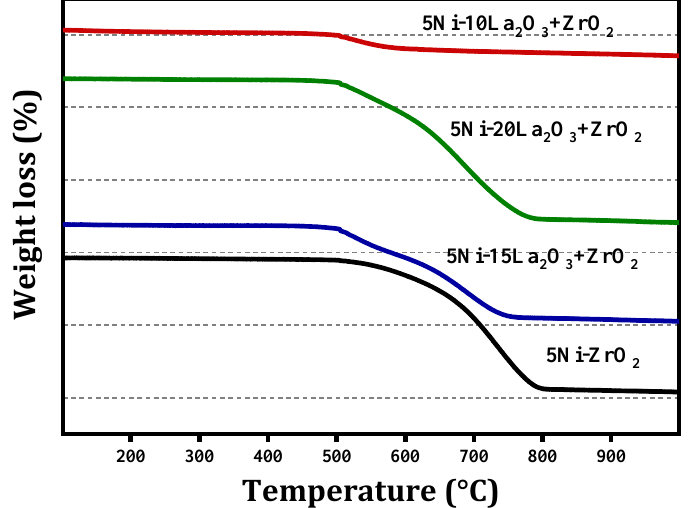
Figure 9. Thermogravimetric analysis (TGA) curves quantify the amount of carbon deposited over the used catalysts.